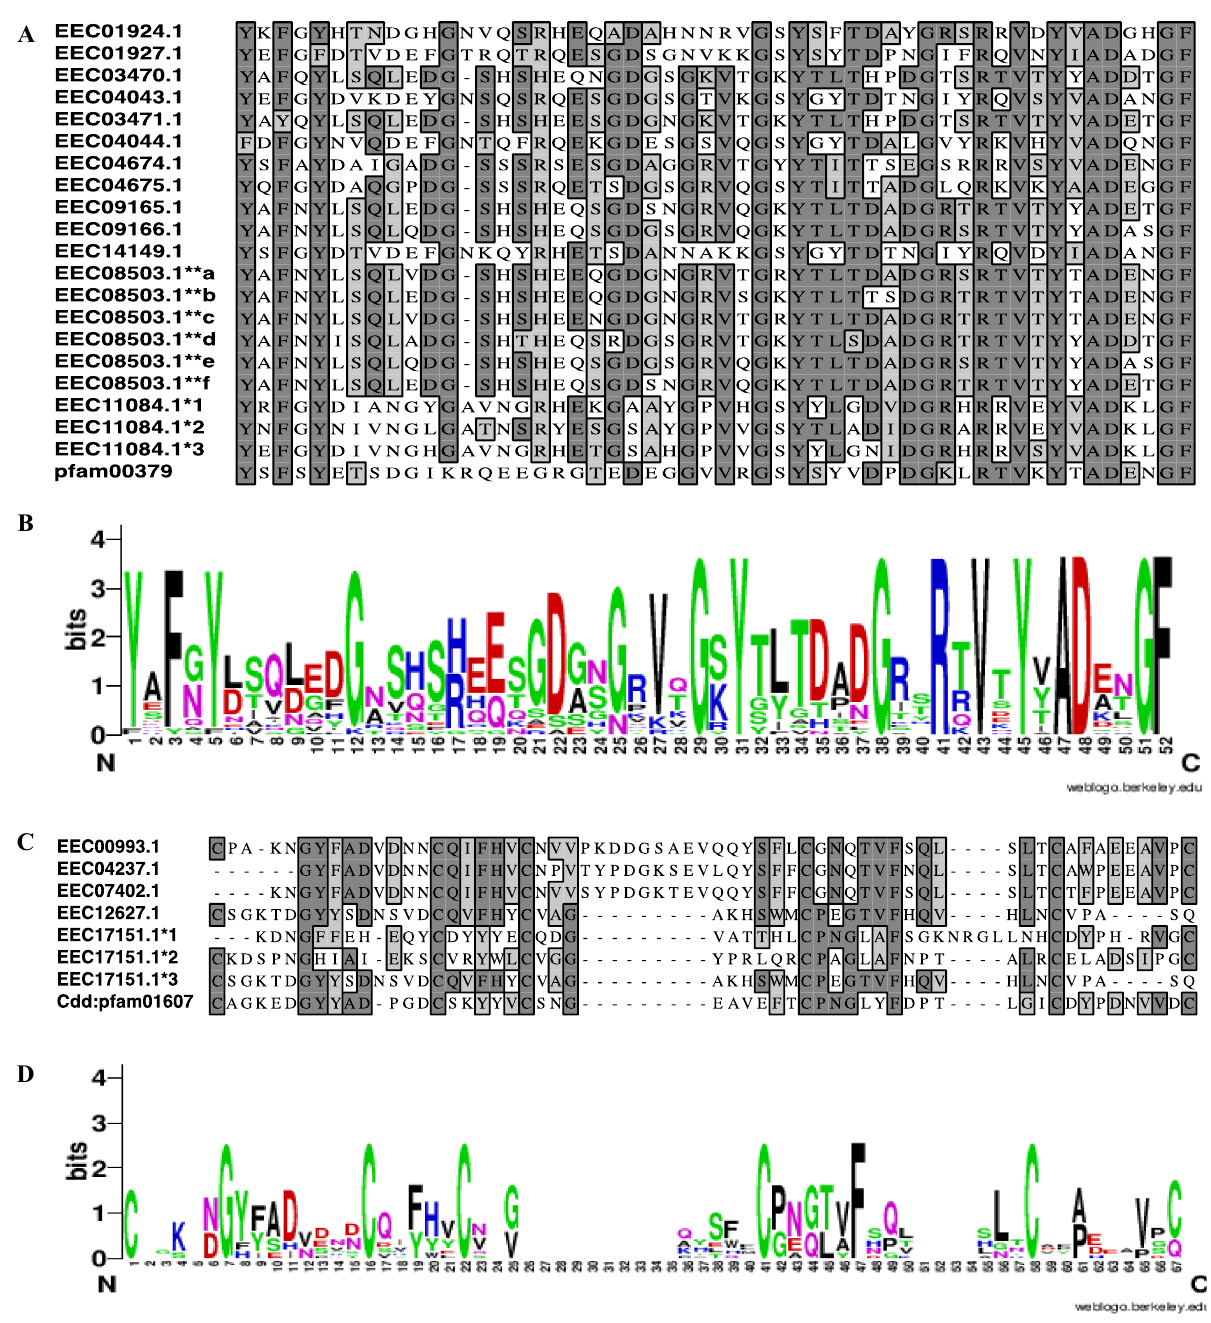
Figure 4. Sequence Logo for putative binding domains of chitin (pfam00379; Fig. 3A) and carbohydrate (pfam00167; Fig. 3C) in tick cement cuticle proteins. The pfam00379 and pfam00167 motifs as identified on the NCBI were aligned in MacVector (Fig. 3A,C) and sequence logos (Fig. 3B,D) visualized on the WebLogo server (https:// weblo go. berke ley. edu/). 1** a–f and 1* 1–3 = pfam motifs in EEC08503 and EEC11084.1 and pfam01607 in